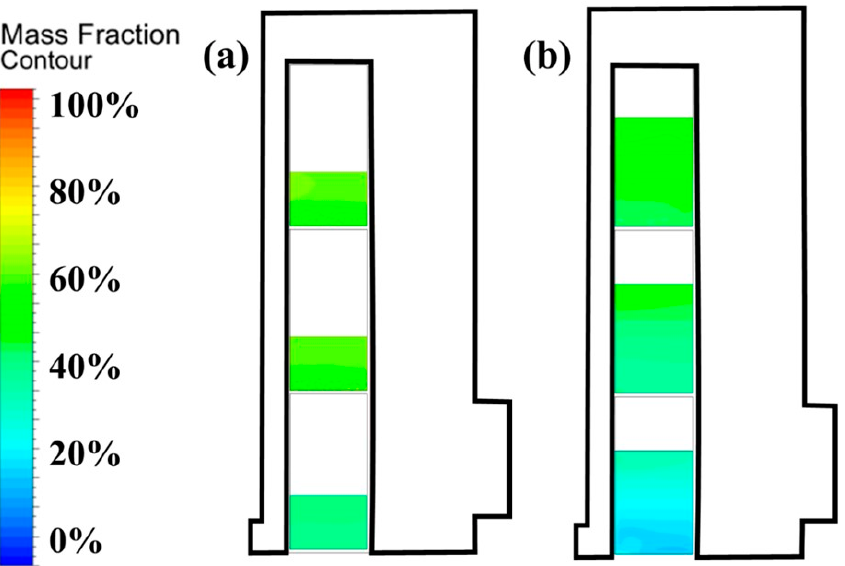
Figure 9. PCM melting rate when the solar irradiance of 900 W/m 2 is supplied for 10,000 s. ( a ) 33%, ( b ) 66% PCM charged in storage.